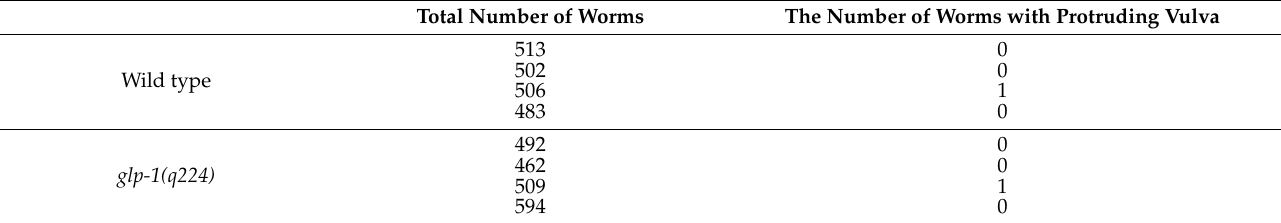
Table A3. The vulva malformation of N2 and glp-1 worms cultured at 25 ◦